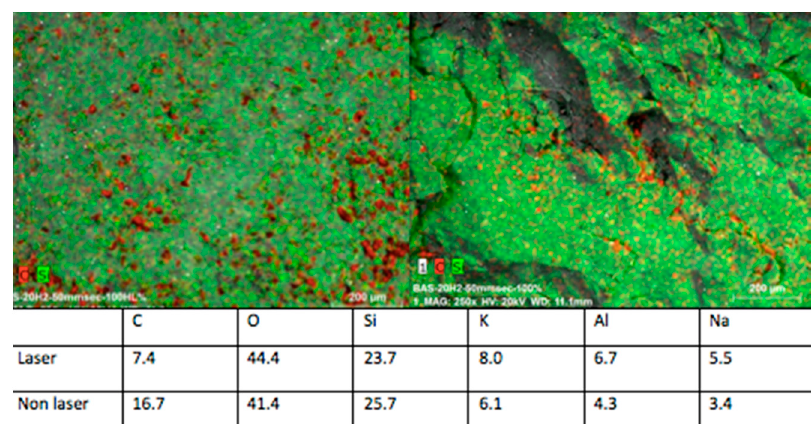
Figure 8. ( Left ) Control group and ( right ) samples irradiated with peak power of 10 kW, and a speed of 50 mm/s: the C concentration is shown in red.